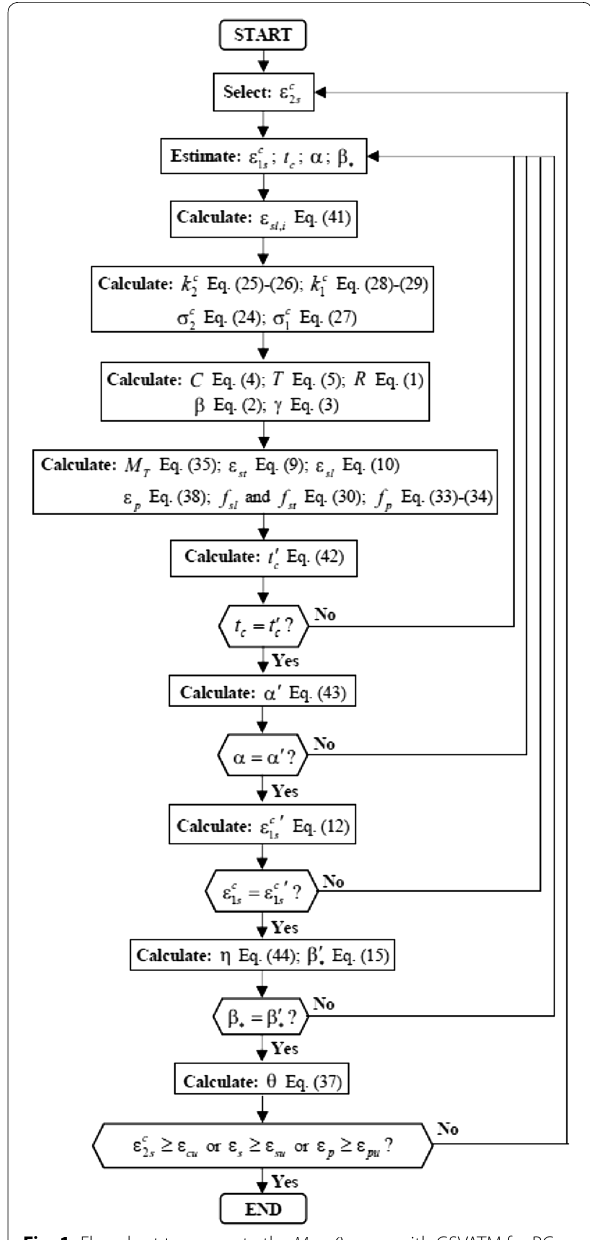
Fig. 1 Flowchart to compute the M T − θ curve with GSVATM for PC